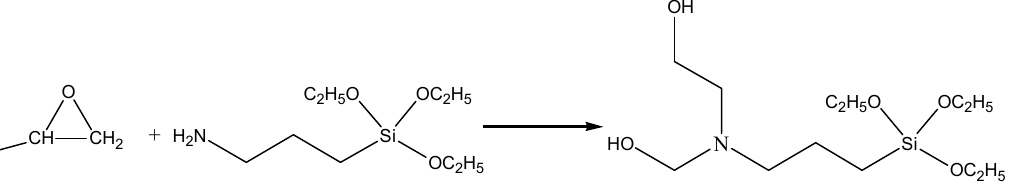
Figure 1. FTIR spectra of polydimethylsiloxane (PDMS), E51 and coating ES-30.